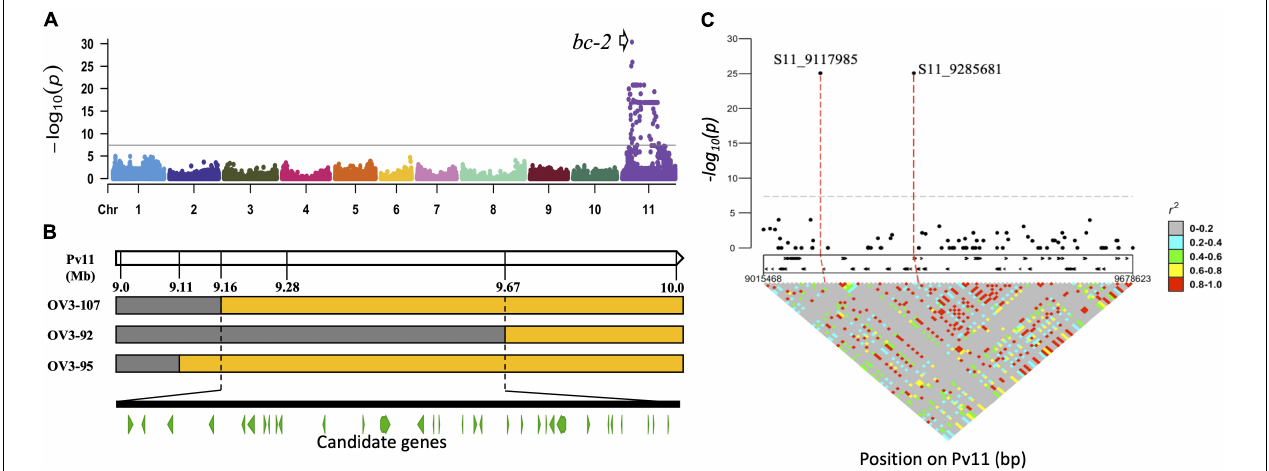
FIGURE 1 | Detection and physical position of bc-2 gene on Pv11. (A) Genome-wide association study (GWAS) between Durango Diversity Panel (DDP) lines with no symptoms when inoculated with either NL-3 or US-6 strains vs. DDP lines exhibiting mosaic to both strains or top necrosis (TN), mild mosaic (mM), or vein